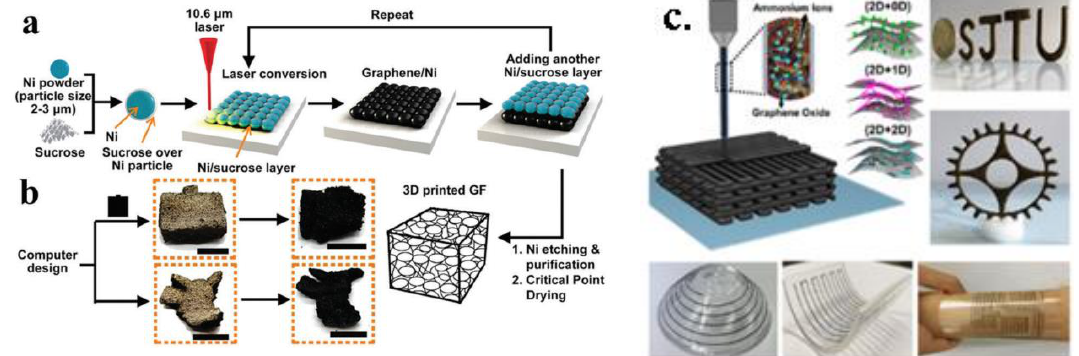
Figure 7. ( a ) Diagram of an in situ 3D GF synthesis method that simulates 3D printing. Reprinted with permission from Ref. [65]. Copyright © 2017, American Chemical Society, ( b ) images of 3D- printed GF taken before and after the Ni was dissolved. Reprinted with permission from Ref. [65]. Copyright © 2017, American Chemical Society. ( c ) Mixed-dimensional hybrid aerogels based on graphene. Reprinted with permission from Ref. [66]. Copyright © 2018, American Chemical Society.